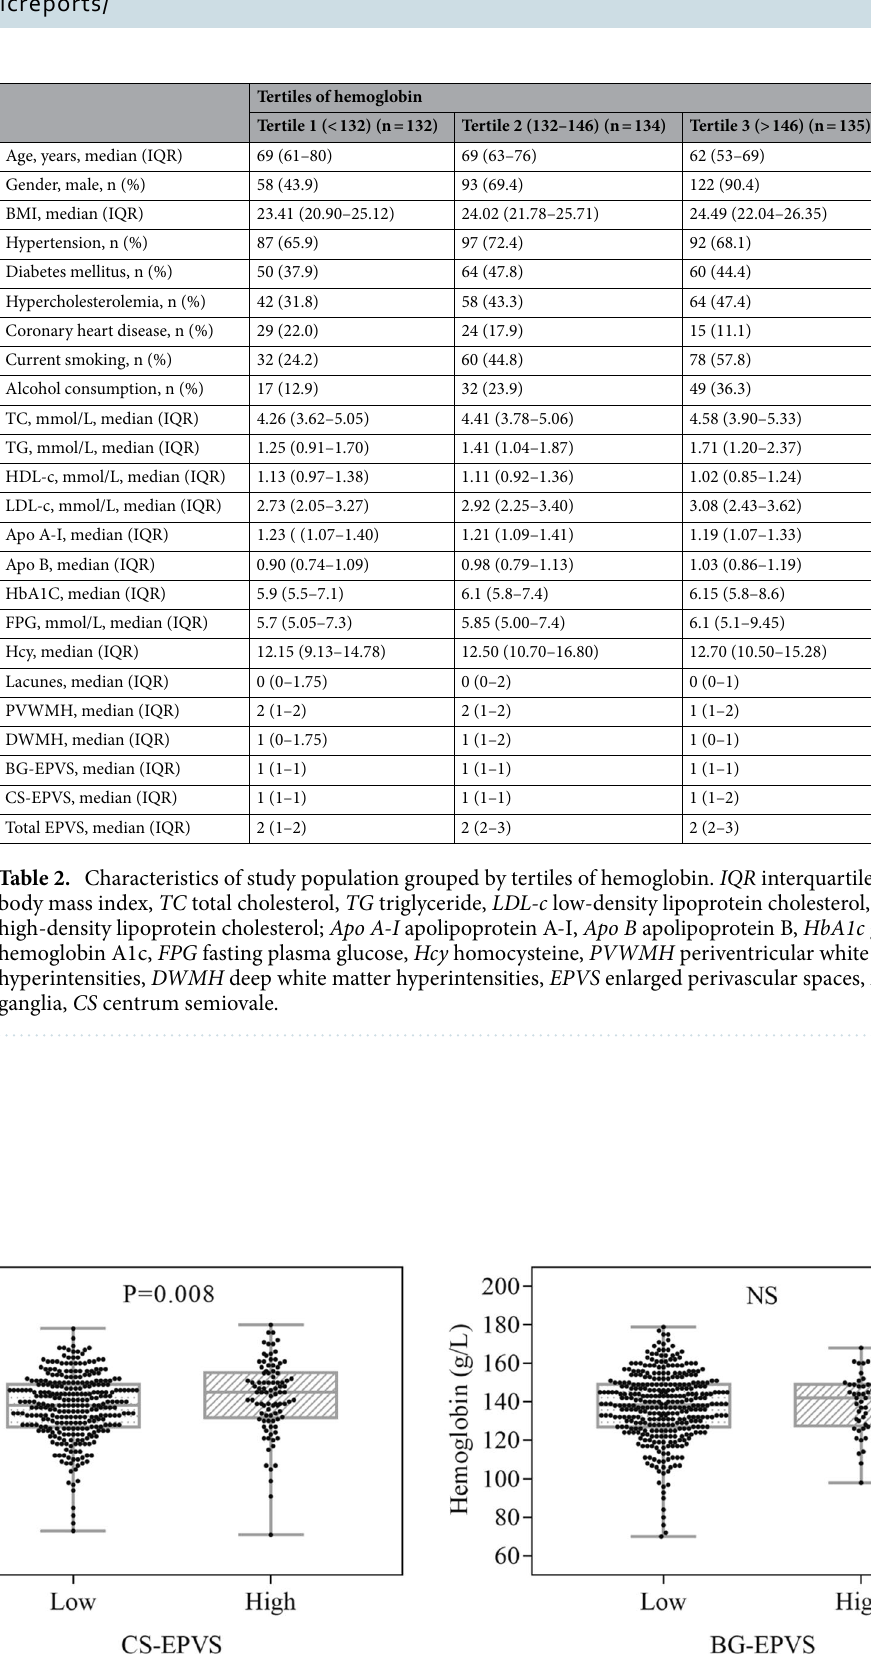
Figure 3. Comparison of the level of hemoglobin between patients with high and low EPVS degree in BG and CS. Box plots for hemoglobin according to the degree of EPVS in CS and BG. Bars show median values, boxes are the 25th and 75th percentiles (interquartile range, IQR), and the ends of the vertical lines are the lowest and the highest value. NS not significant, EPVS enlarged perivascular spaces, BG basal ganglia, CS centrum